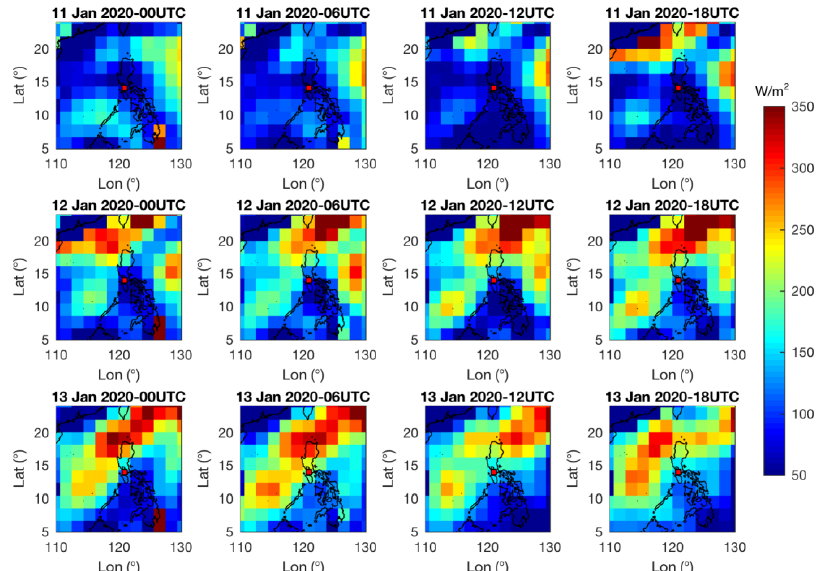
Figure 17. Spatial variations of surface latent heat flux at 00, 06, 12, and 18 UTC around the Taal volcano from 11 to 13 January 2020. The red square indicates the Taal volcano.